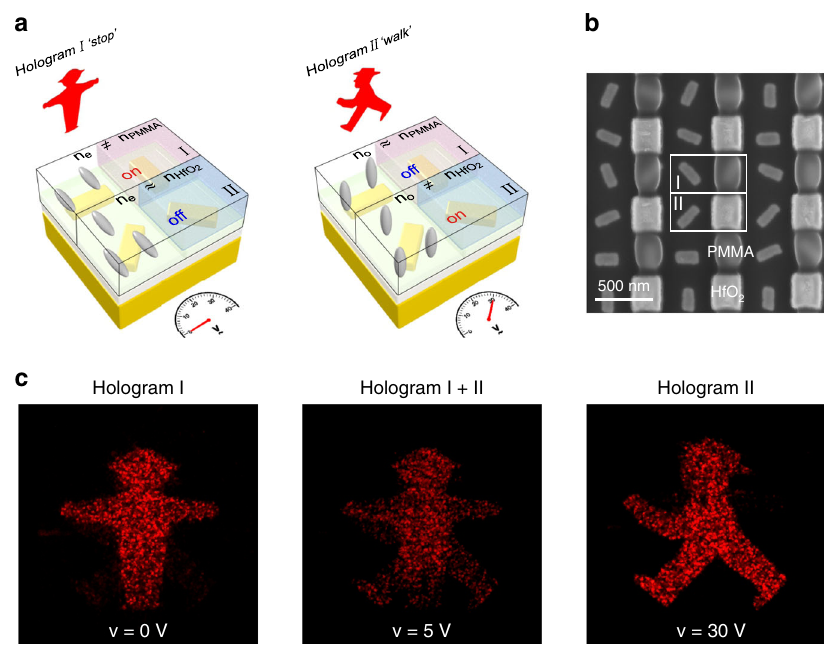
Fig. 5 Electrically-controlled dynamic holograms. a Schematic of the electrically-controlled metasurface device for switchable holograms between “ stop ” and “ walk ” signs. b SEM image of the metasurface with selective PMMA and HfO 2 coating. c Experimental results. Captured holographic images in the far fi eld at different applied